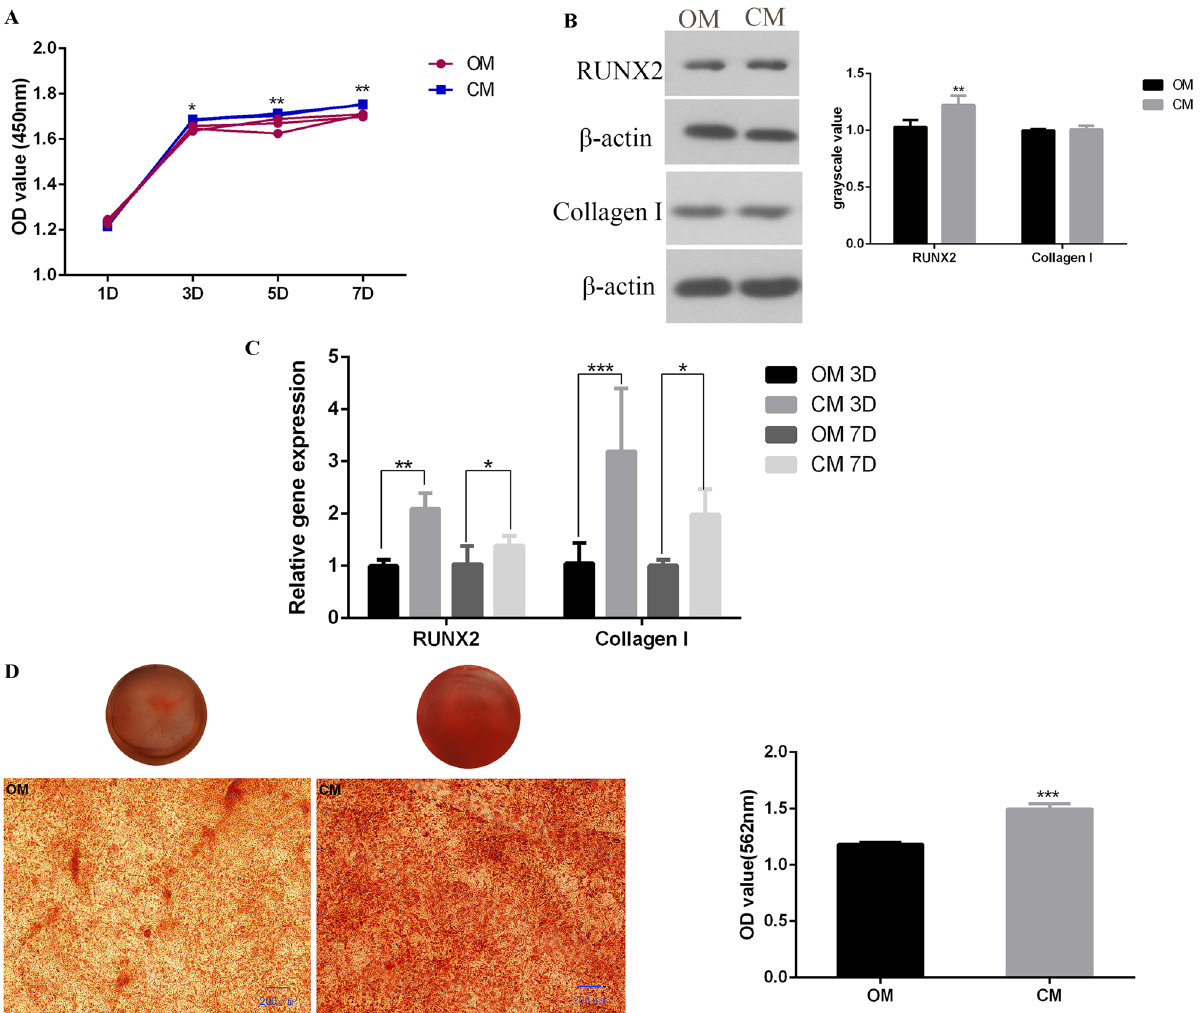
Figure 3. Comparison of the proliferation, differentiation and mineralization levels of osteoblasts stimulated with or without macrophage medium supernatant. ( A ) CCK-8 was used to detect the proliferation activity of MC3T3-E1 cells at 1, 3, 5, 7 days; ( B ) western blot showed the expression of osteogenic related proteins runx2 and collagen I at 7 days; ( C ) real-time PCR showed the expression of osteogenic marker genes runx2 and collagen I at 3 and 7 days; ( D ) alizarin red showed the mineralization of MC3T3-E1 cells [ OM osteogenic induction medium, CM conditional medium (osteogenic induction medium and the supernatant of RAW264.7 cells’ culture medium). * p < 0.05; ** p < 0.01; *** p <